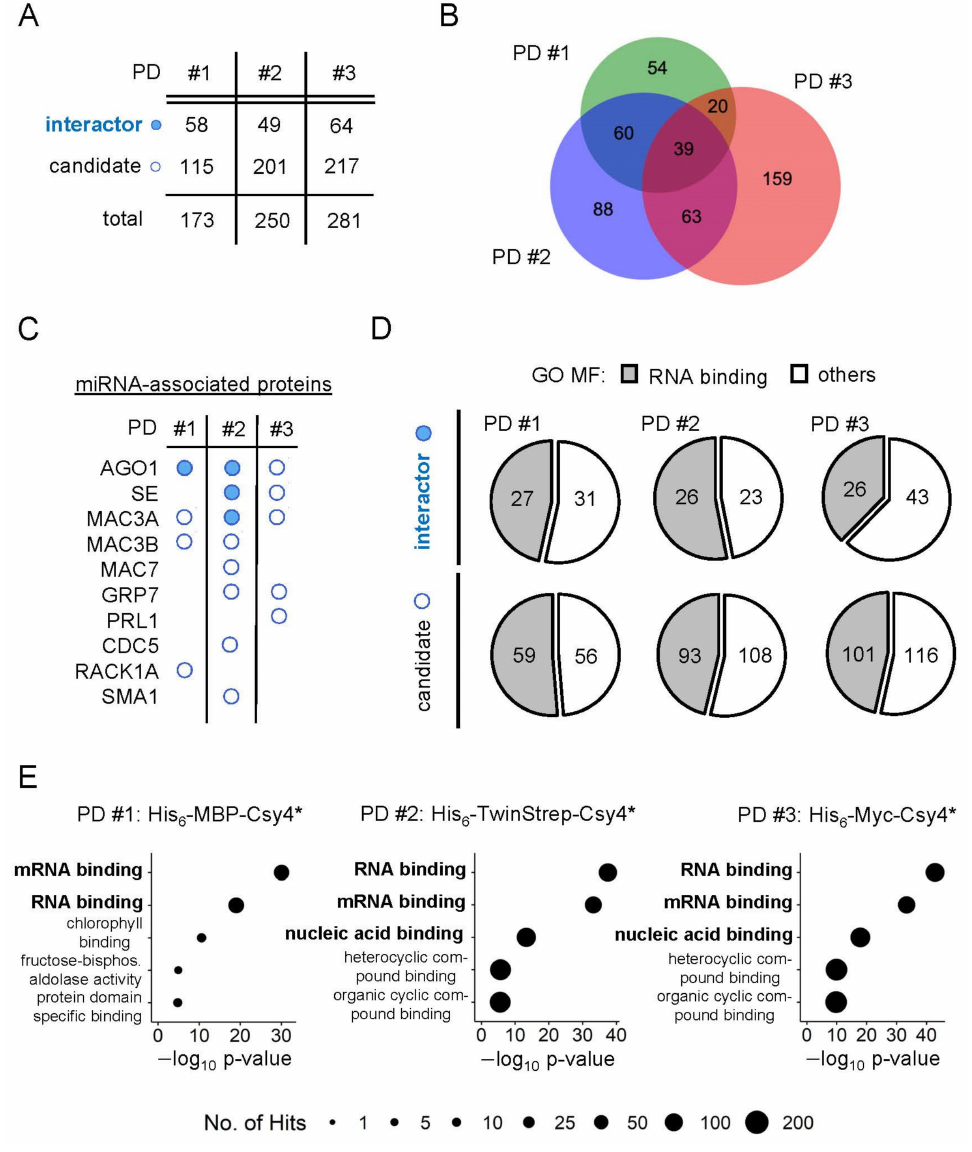
Figure 2. In silico analysis of co-purified proteins. ( A ) Number of co-purifying proteins which were classified as interactors or candidates. ( B ) Overlap of co-purified proteins (combined interactors and candidates) between the three Csy4*-based RNA pulldowns. ( C ) Co-purified proteins already known to be associated with miRNA biogenesis. ( D ) Proportion of interactors and candidates of each pulldown that are associated with RNA-binding related molecular function (MF) GO